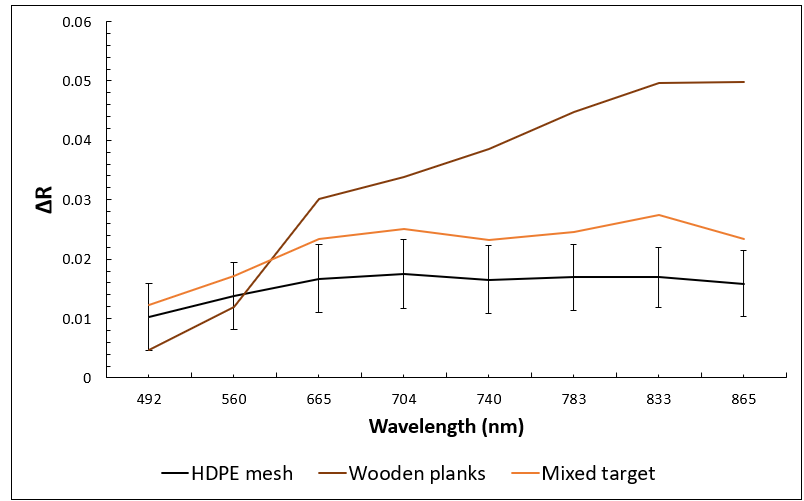
Figure 4. Sentinel-2 spectral plots of the three different target materials; bottom plot omitting the two SWIR bands, error bars standard deviation of HDPE mesh target central pixel reflectance values.